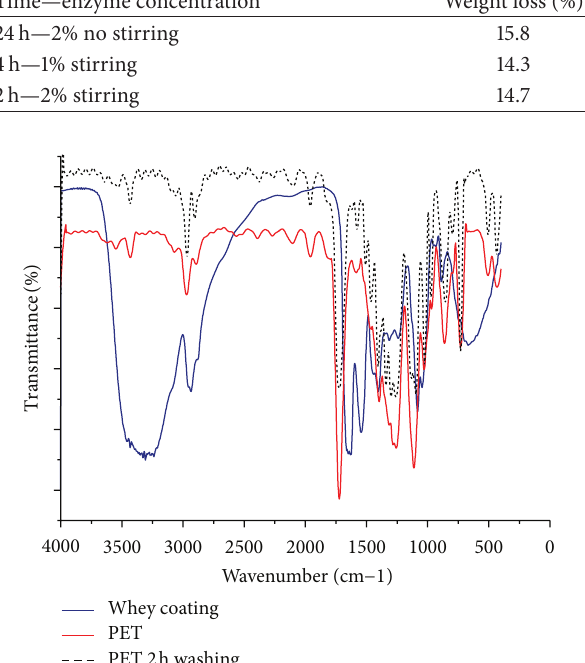
Figure 4: FT-IR spectra of PET, whey coating and coated PET after 2 h